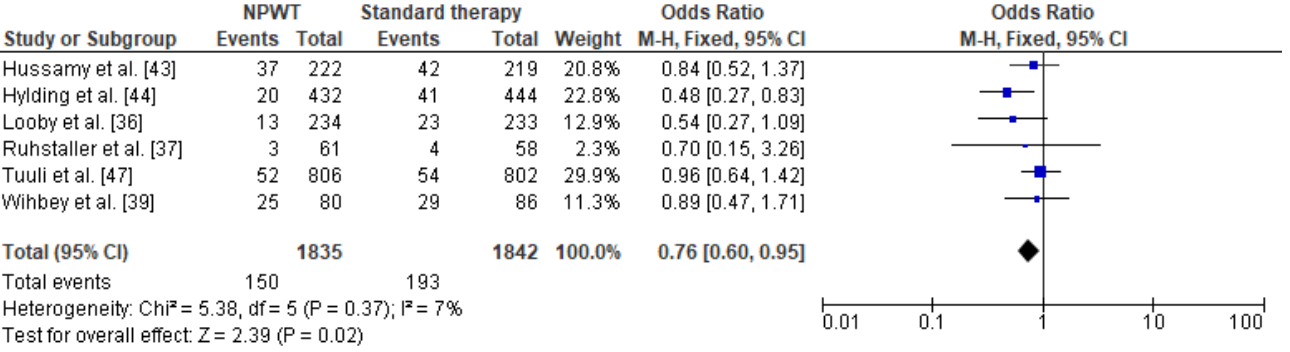
Figure 6. Forest plot for surgical site infection in the group of post-caesarean obese women with NPWT and in obese women with standard therapy. NPWT—negative pressure wound therapy; M.-H.—Mantel-Haenszel; CI—confidence interval; I 2 —heterogeneity; df—degrees of freedom.